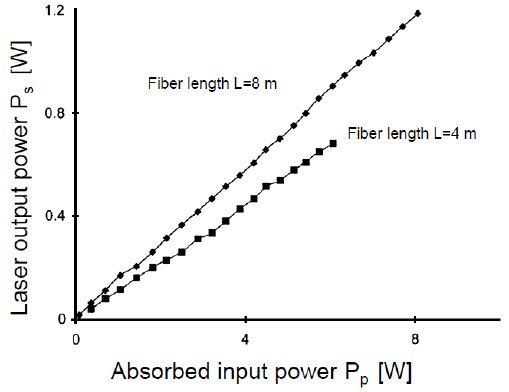
Figure 5. Characteristics of the Er 3+ -doped fluoride glass fiber laser [25]. Figure adapted from [25].